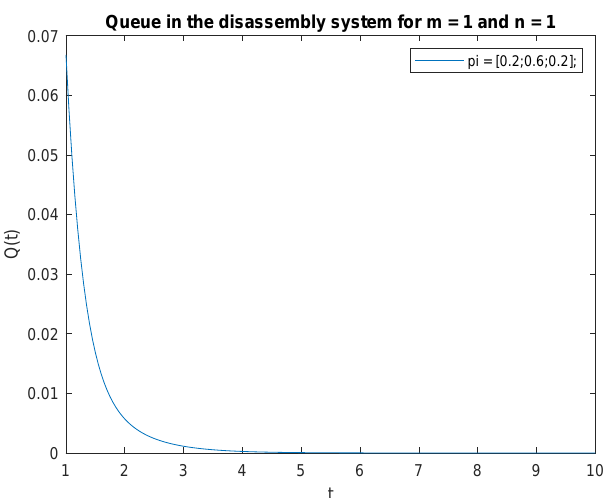
Figure 19. Impact of traffic load described by p i = { 0.2,0.3,0.5 } on P { X ( t ) = m = 1 | X ( 0 ) = n = 1 } for λ = 4.